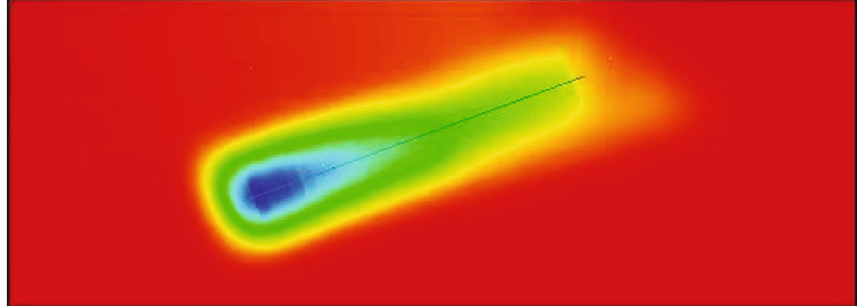
Figure 12: Saturation distribution of 5 days well shut-in.